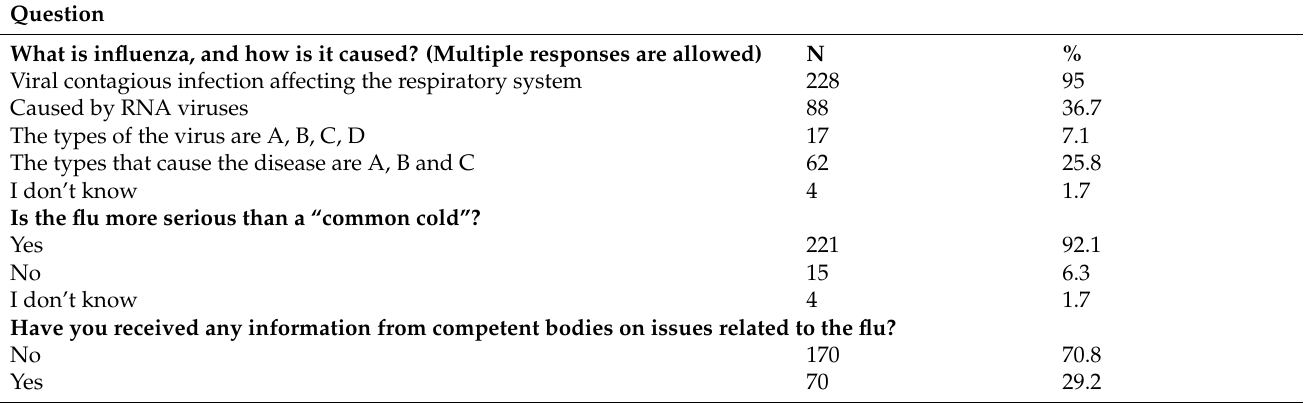
Table 2. Healthcare professionals’ knowledge about the flu and methods of transmission and